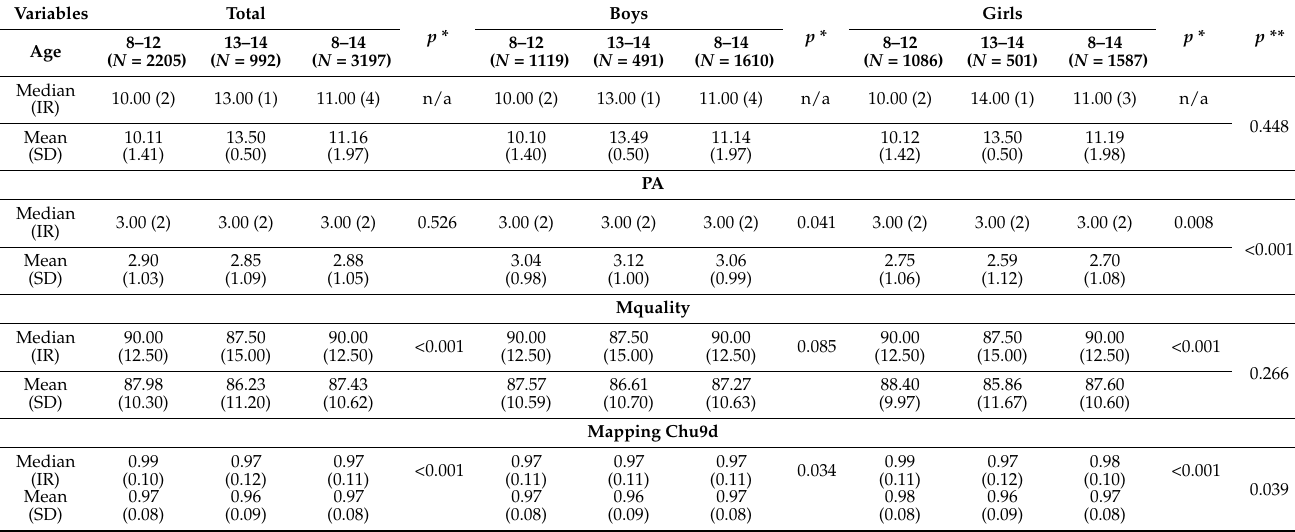
Table 1. Descriptive statistics for age, HRQoL and physical activity for total sample and by sex and age. Variables